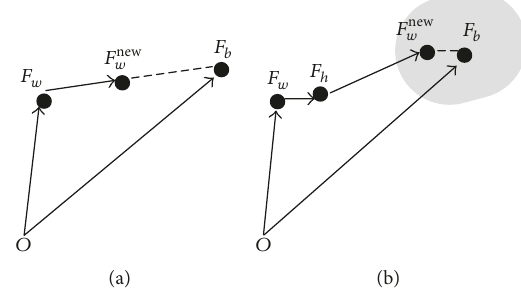
Figure 1: The rules schematic of